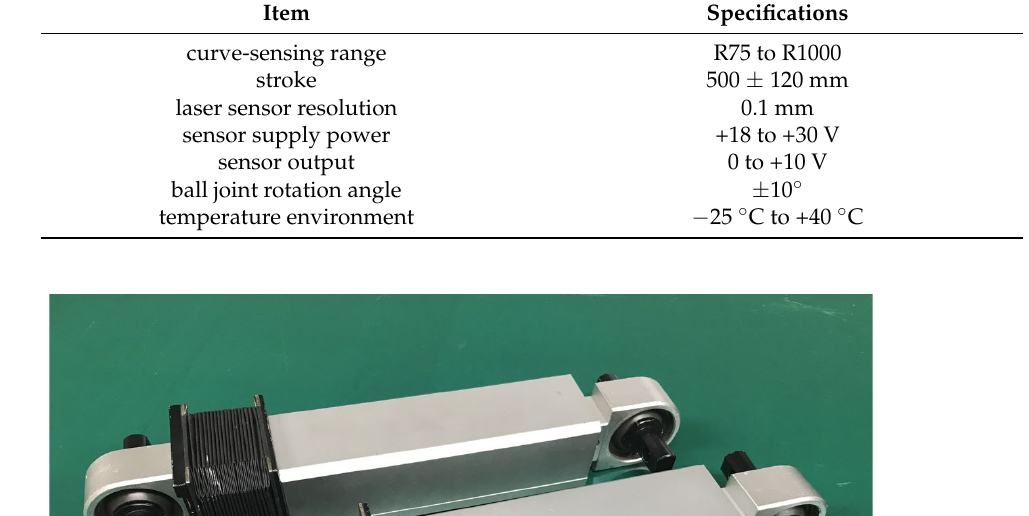
Figure 13. Functional test for curvature sensor. Table 3 shows the functional test results for the curvature sensor prototype. The error was confirmed to be between − 1.26% and 1.36% and it is expected that the manufactured curvature sensor prototype will show good curvature measurement performance. Table 3. Functional test result for the curvature sensor. Radius (m)